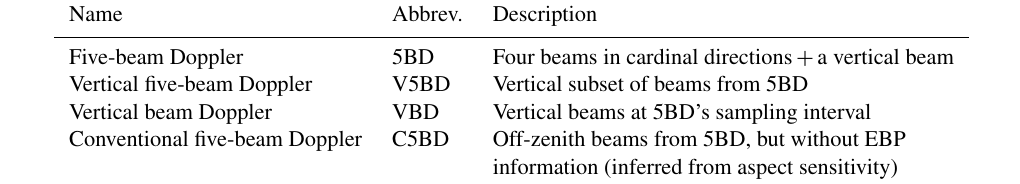
Table 3. Summary of different Doppler techniques referred to in this paper. See Sect. 3.1.2 for more details on each technique. Name